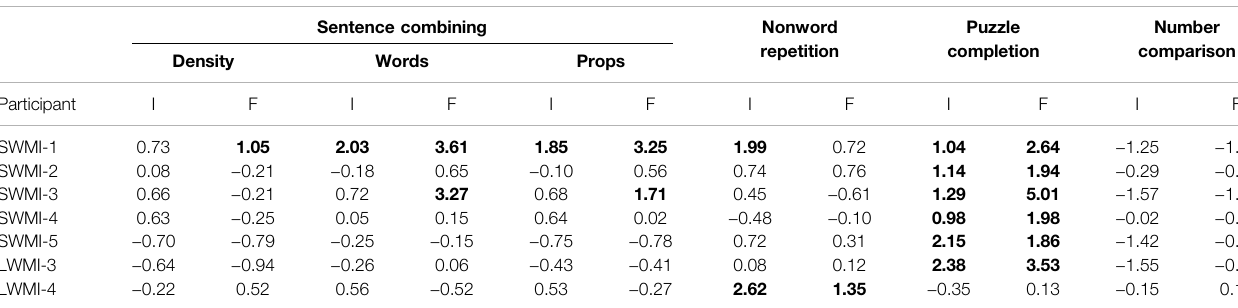
TABLE 3 | Effect sizes of probe